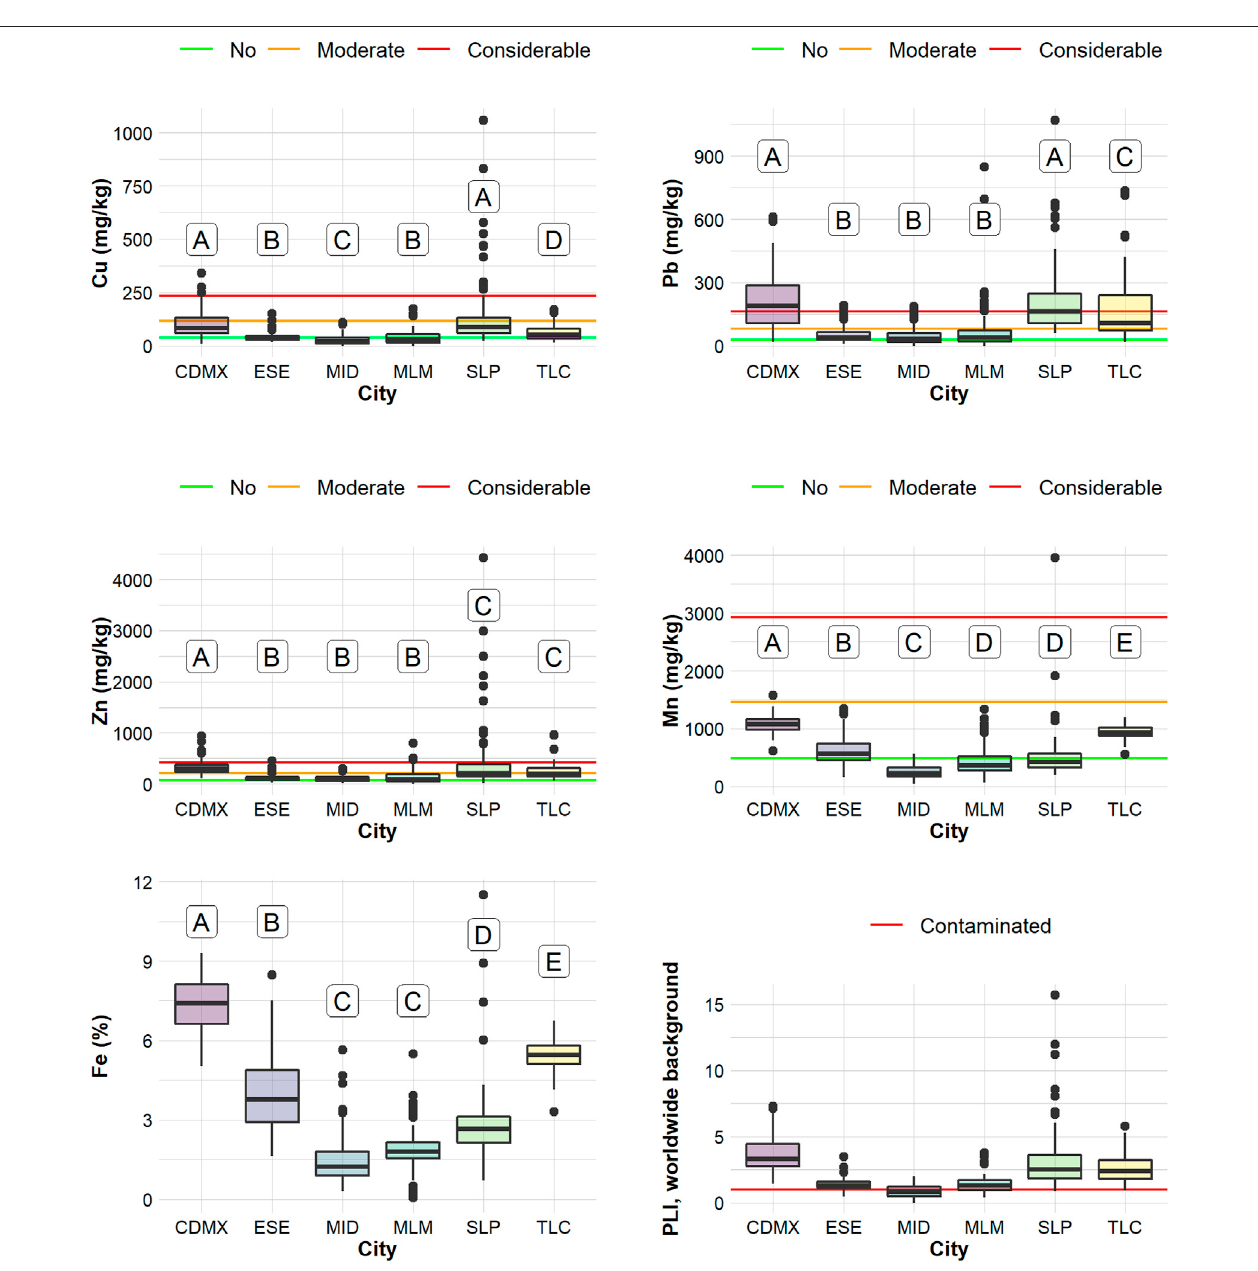
FIGURE 1 | Boxplots of the heavy metal concentrations. Different letters indicate signi fi cant differences. CDMX: Mexico City, ESE: Ensenada, MID: Mérida, MLM: Morelia,SLP:SanLuisPotosí,TCL:Toluca.PLI:pollutionloadindex. Horizontallinesrepresent thecontaminationlevelsusingthebackgroundvalueestablished forsoils worldwide (Kabata-Pendias